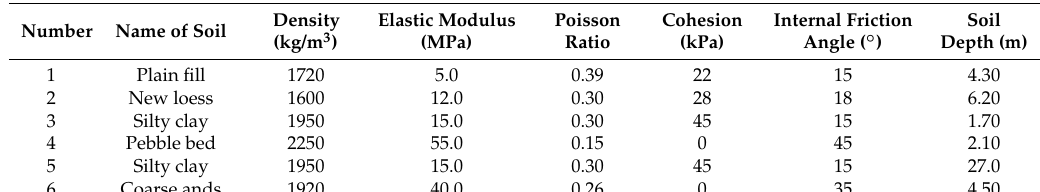
Table 1. The physical and mechanical soil parameters.